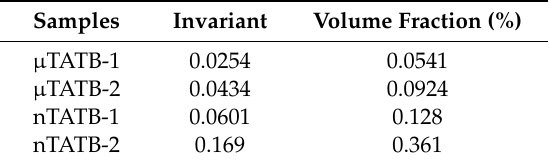
Table 3. The volume fraction values using Porod Invariant of four TATB